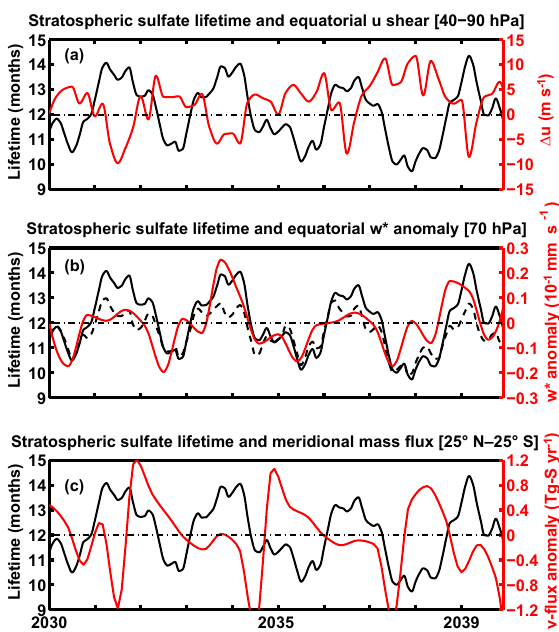
Figure 5. (a) Monthly means of geoengineering SO 4 lifetime (black; left scale; months) and equatorial zonal wind shear be- tween 40 and 90hPa (red; right scale; ms − 1 ) in the ULAQ- CCM (years 2030–2039). (b) SO 4 lifetime, as in (a) but com- pared against the 70hPa equatorial w ∗ anomalies (red; right scale; mms − 1 ). The calculated average lifetime of stratospheric sulfate from geoengineering sulfur injection of 8TgSO 2 yr − 1 is 12.1 ± 1.2 months in ULAQ-CCM (with an equatorial residual ver- tical velocity w ∗ = 0.22 ± 0.12mms − 1 , as a time average between 20 and 70hPa). The average lifetime decreases to 11.6 ± 0.6 months when using winds from the baseline simulation, i.e., in a CTM ap- proach (black dashed curve) (see text for discussion). (c) SO 4 life- time, as in (a) but compared against the net poleward meridional sulfate mass flux anomalies integrated above the tropopause at the subtropical barriers at 25 ◦ S and 25 ◦ N (red; right scale; TgSyr − 1 ). The meridional flux is defined as v × [SO 4 ] and defined as pos- itive when poleward, i.e., (cid:56) V = v [SO 4 ](25 ◦ N) – v [SO 4 ](25 ◦ S), where v is the meridional wind and [SO 4 ] the sulfate concentration ( (cid:56) V = 2.55 ± 0.56TgSyr − 1